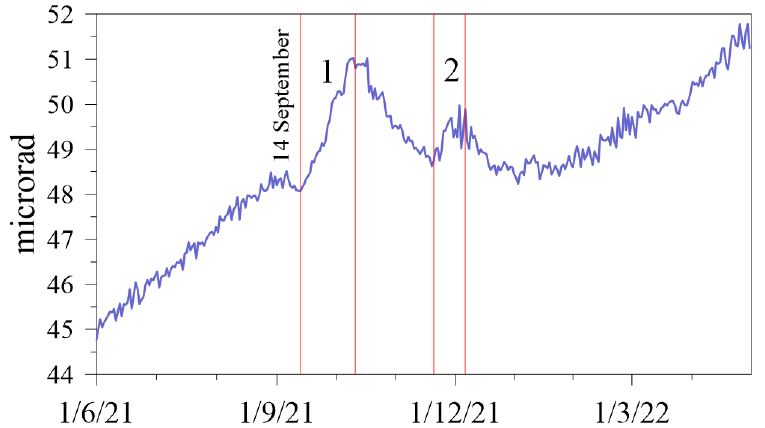
Figure 19. The radial component of the SLT station (Figure 1c) shows the two phases (with a duration of 30 (1) and 15 (2) days) of tilt increases, indicating an uplift towards La Fossa Crater. Changes occurred within an upward long-term trend, which began in 2016.